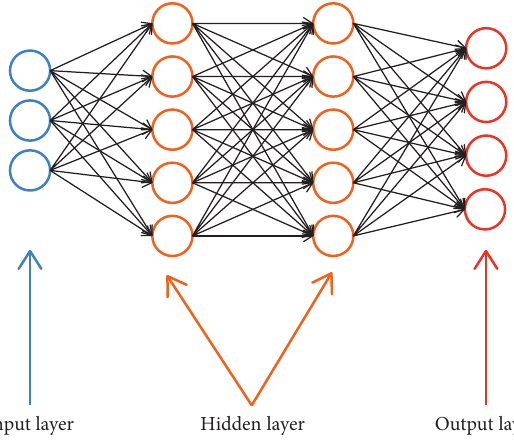
Figure 9: Multilayer perceptual neural